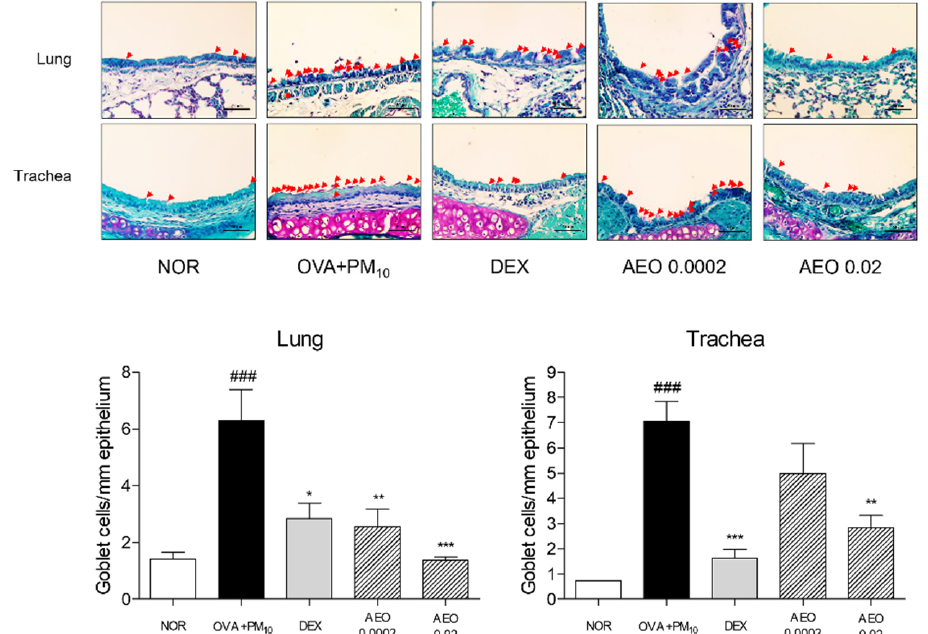
Figure 3. Goblet cell population per area of lung and trachea tissues stained by PAS. Magnification is ×400. Red arrowheads indicate PAS-positive purpled goblet cells. Results are presented as mean ± standard error of the mean. ### p < 0.001 vs. NOR group; * p < 0.05, ** p < 0.01 and *** p < 0.001 vs. OVA+PM 10 group.